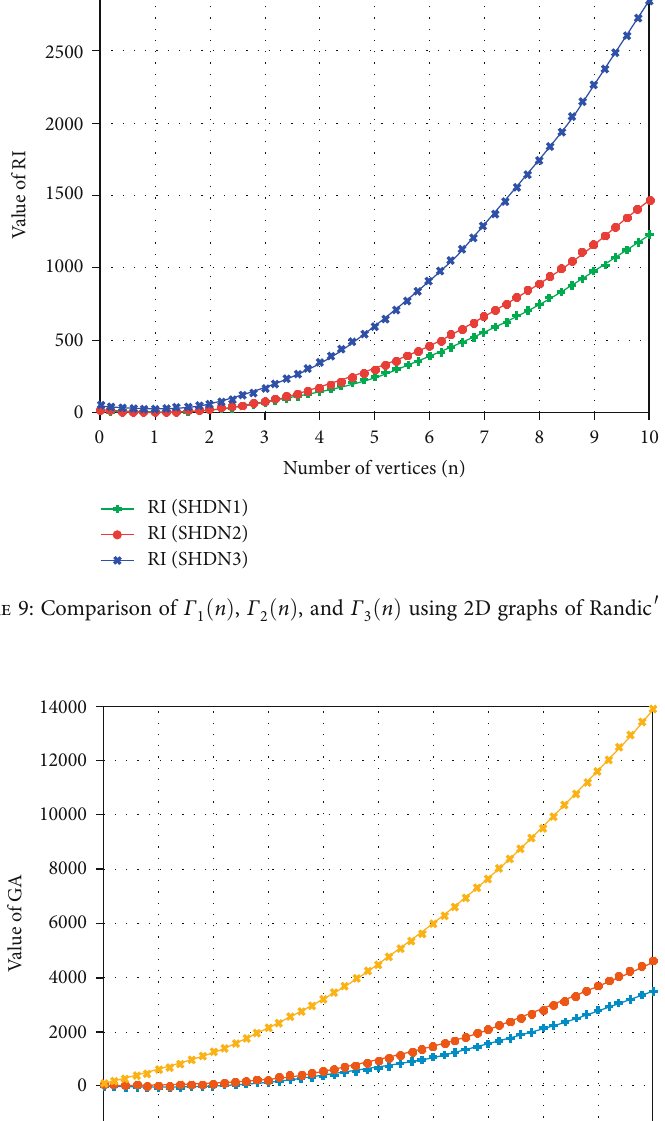
Figure 10: Comparison of Γ